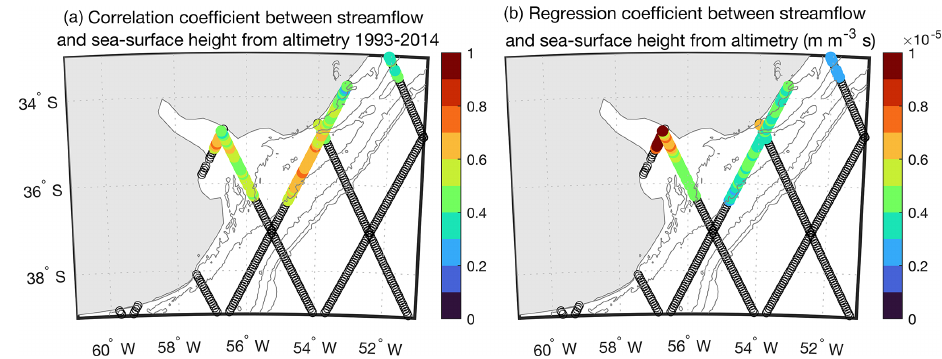
Figure 12. (a) Correlation coefficient and (b) regression coefficient (mm − 3 s) between annual streamflow in the Río de la Plata (Fig. 3) and sea surface height anomaly from along-track satellite altimetry data (Birol et al., 2017) during 1993–2014 over the study regions. Values are only shown where correlation coefficients are positive at the 95% confidence level determined through bootstrapping. Contours identify the 20, 50, 100, 200, and 500m